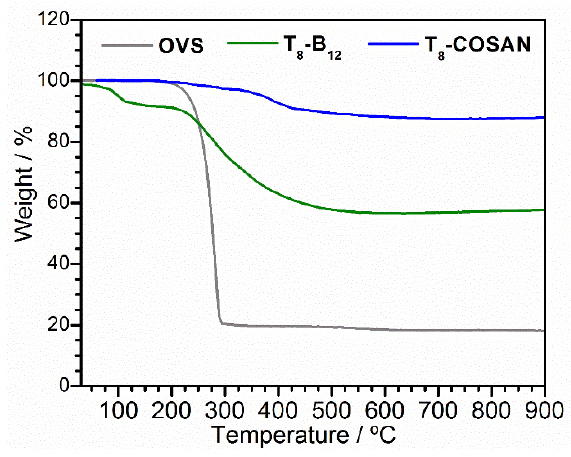
Figure 3. Thermogravimetric analysis (TGA) data under argon (10 °C/min) for octavinylsilsesquioxane (OVS), T 8 -B 12 and T 8 -COSAN .